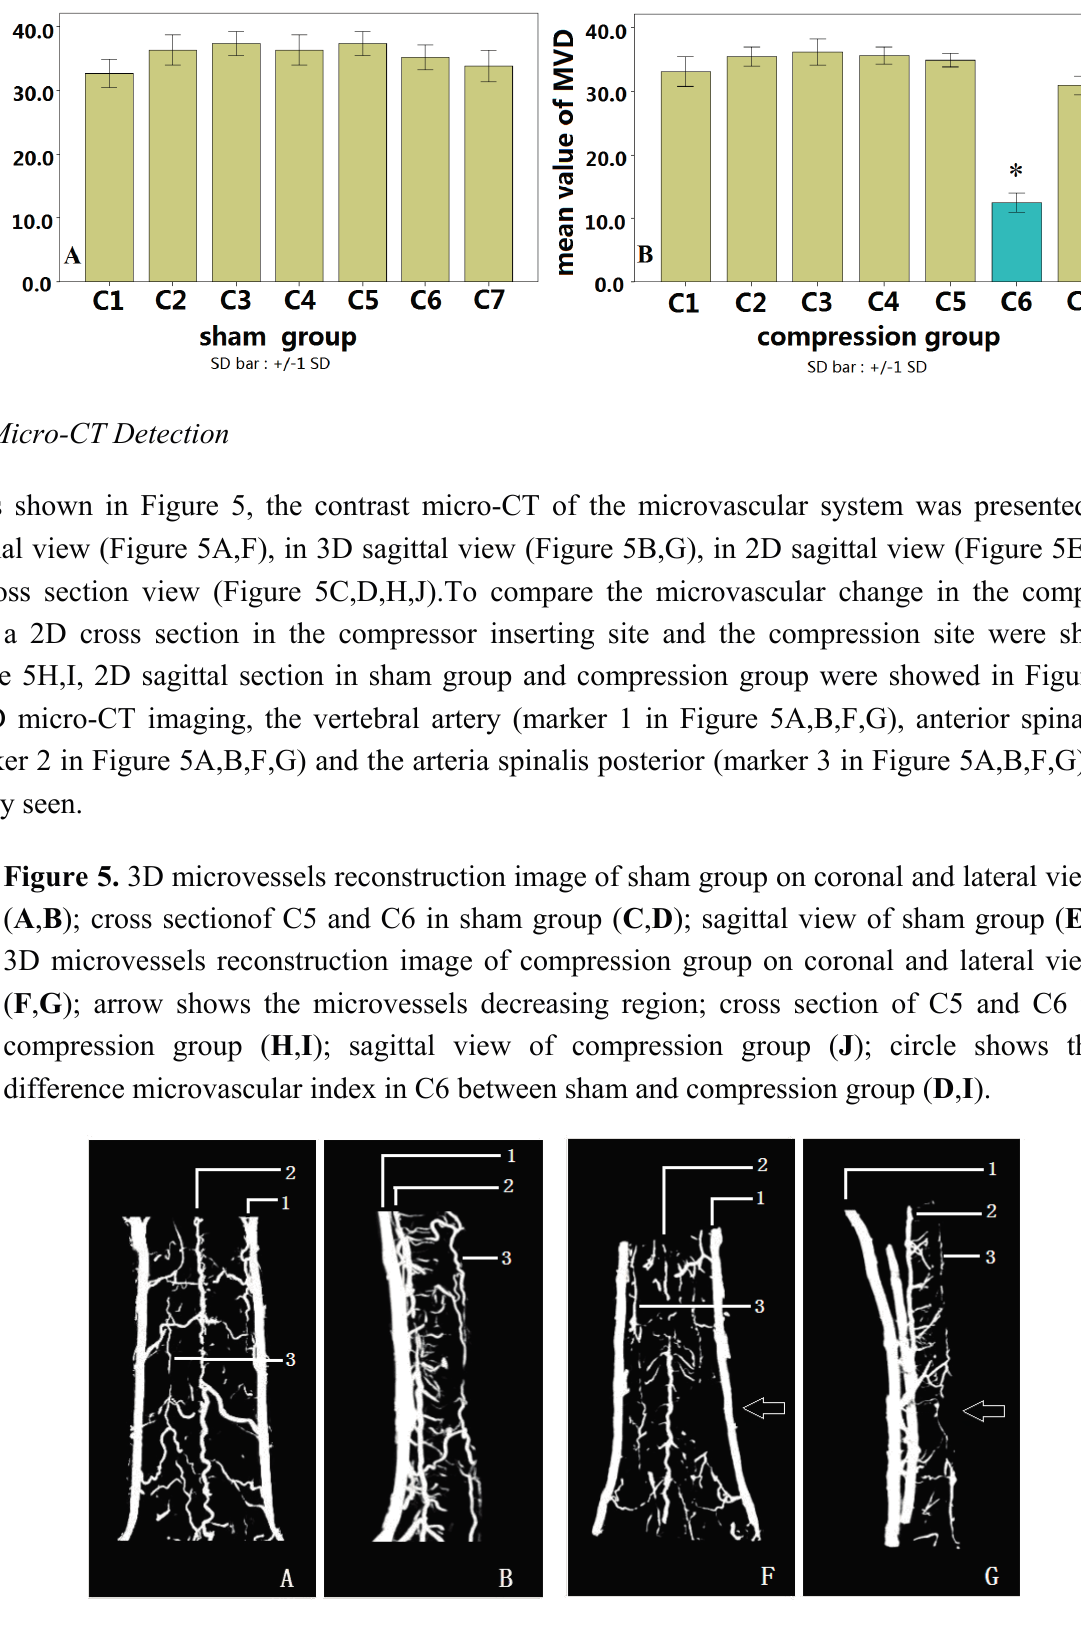
Figure 4. No difference among each segment in the sham group regarding microvessel density (MVD) ( A ); while the mean value of MVD in C6 of the compression group showed significantly lower than that in C6 of the sham group (* p < 0.01) ( B ).